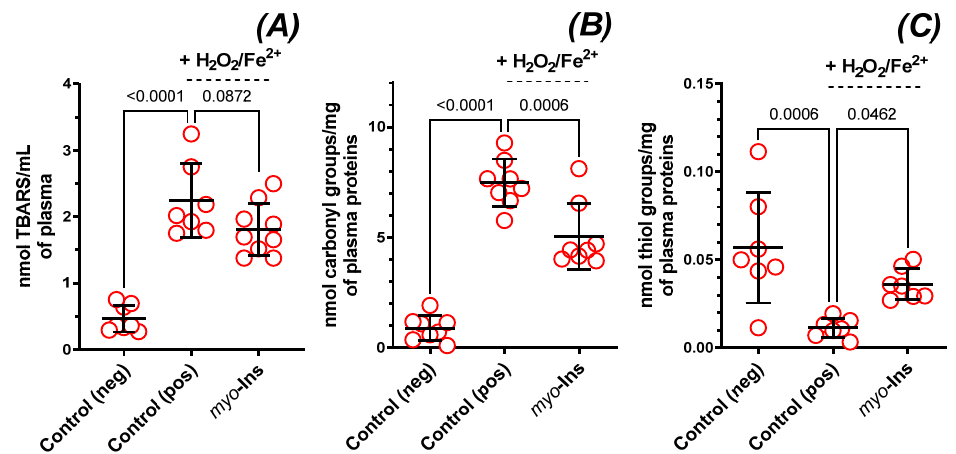
Figure 6. The effect of myo -inositol (1.0 μ M, pre-incubation time—5 min, 37 °C) on the lipid peroxi- dation ( A ), and the oxidative damages of blood plasma protein measured as protein carbonylation ( B ), and the level of thiol groups ( C ) treated with H 2 O 2 /Fe 2+ (incubation time—25 min, 37 °C). Results are given as means ± SD ( n = 9). Control negative refers to the plasma not treated with H 2 O 2 /Fe 2+ , whereas control positive refers to the plasma treated with H 2 O 2 /Fe 2+ . One-way ANOVA followed by a Dunnett’s multiple comparisons test.